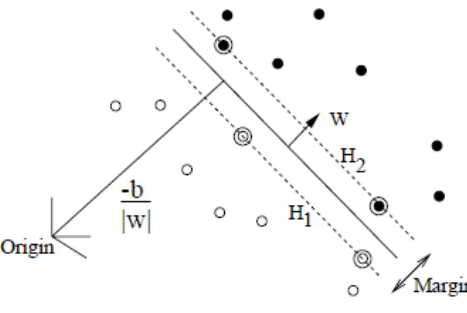
Figure 6. The margin between the two datasets (source: Burges, 1998)